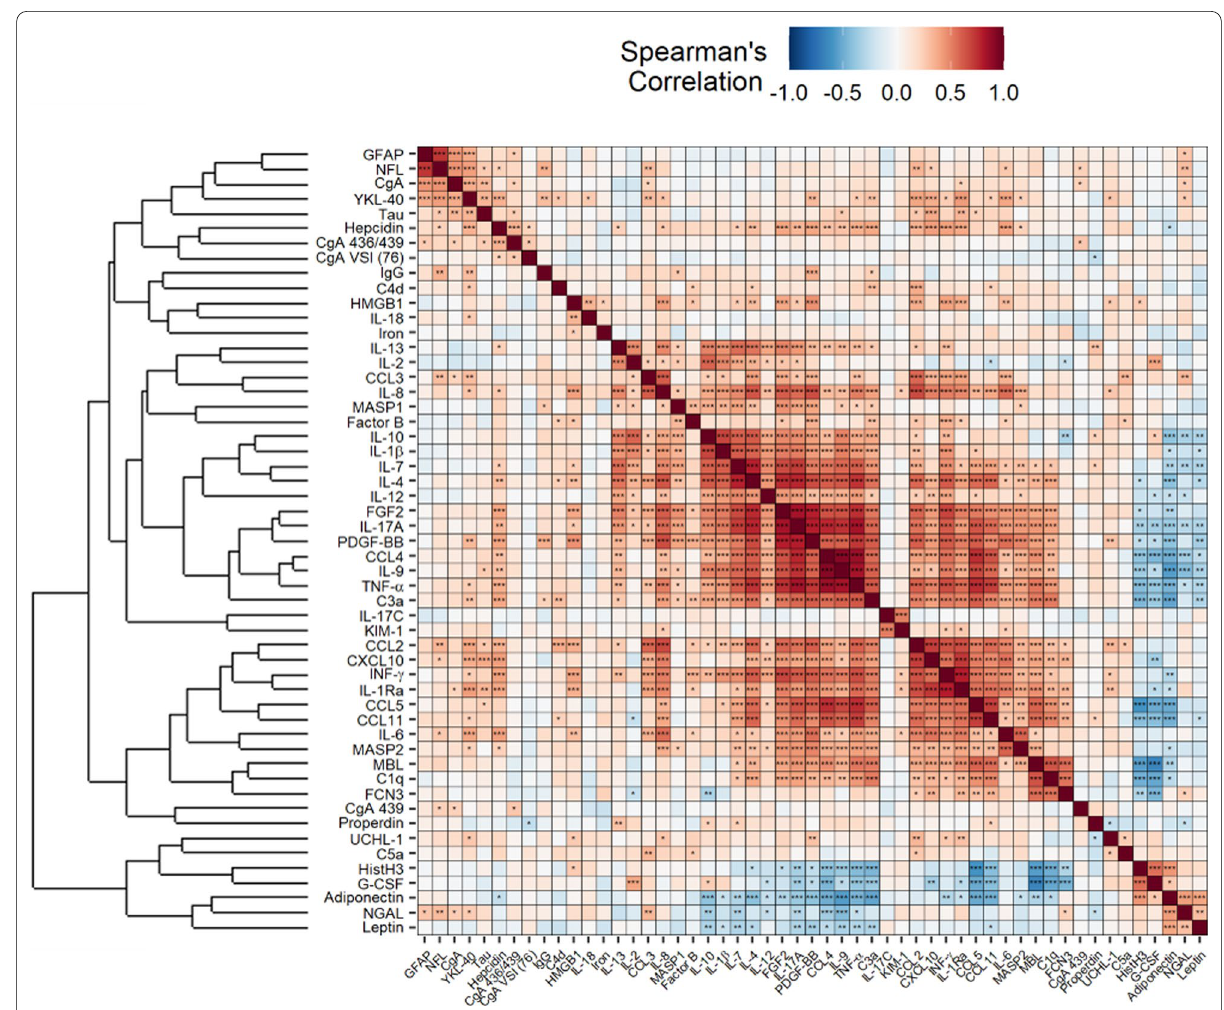
Fig. 6 Spearman’s correlations between biomarker levels and hierarchical cluster analysis. The magnitude of each correlation is denoted with a color, whereby the red color indicates a positive correlation and blue color represents a negative correlation, such that the deeper the color, the stronger is the correlation. IgG anti-SARS-CoV2 spike 1 IgGs. Levels of statistical significance with false discovery rate (FDR) correction are denoted = as: p < 0.05, *p < 0.01, ***p <